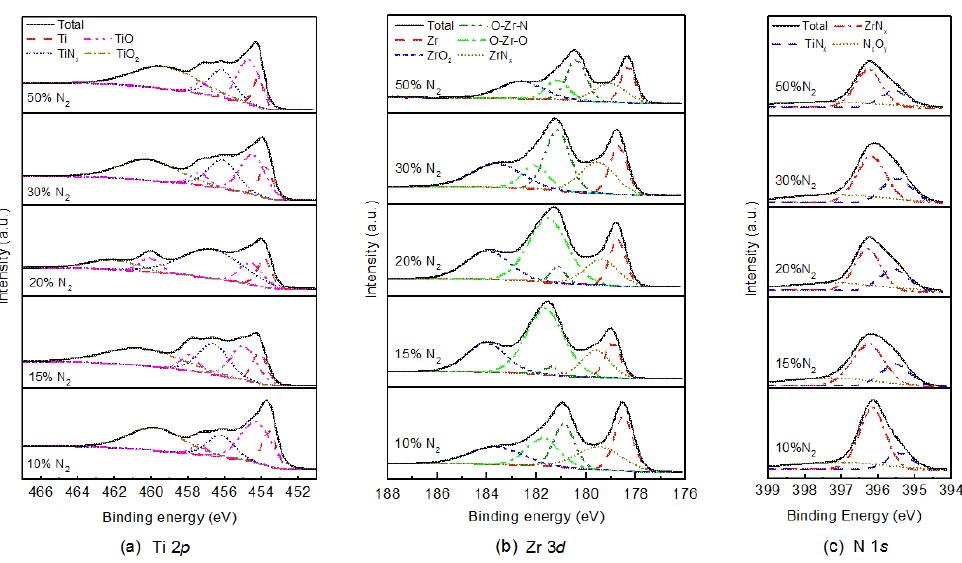
Figure 2. Ti 2 p ( a ), Zr 3 d ( b ) and N 1 s ( c ) XPS spectra of (Ti, Zr)N x films with different nitrogen content. All samples were surface-etched before